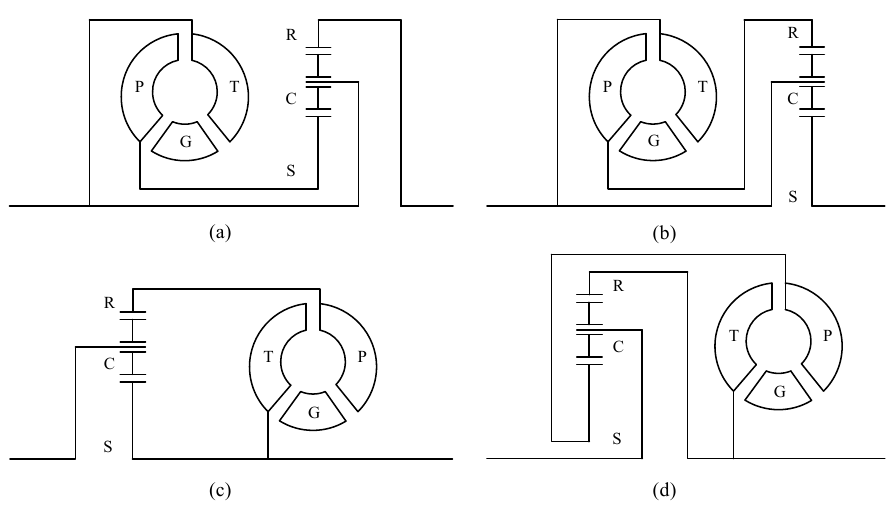
Figure 8. Four reasonable solutions for HMPSTs. ( a ) Solution a ; ( b ) Solution b ; ( c ) Solution c ; ( d ) Solution d .